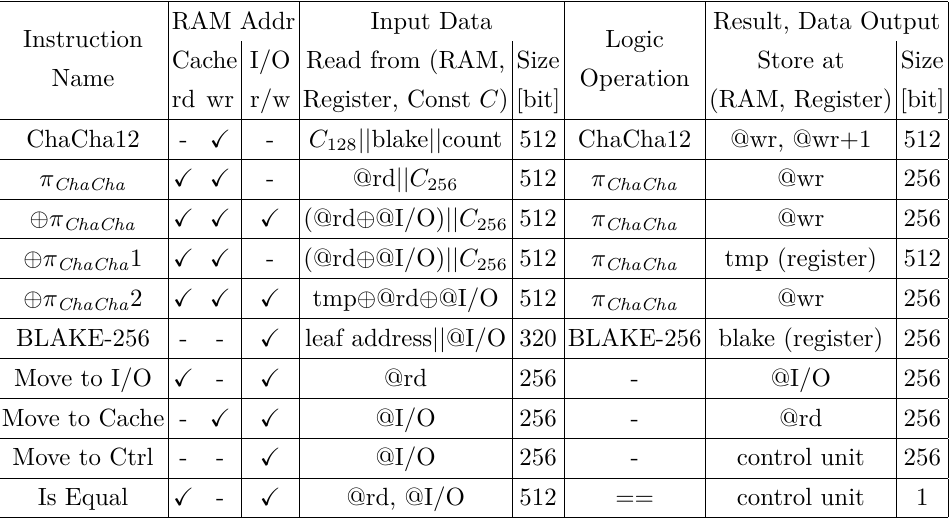
Table 2: Internal instruction set.